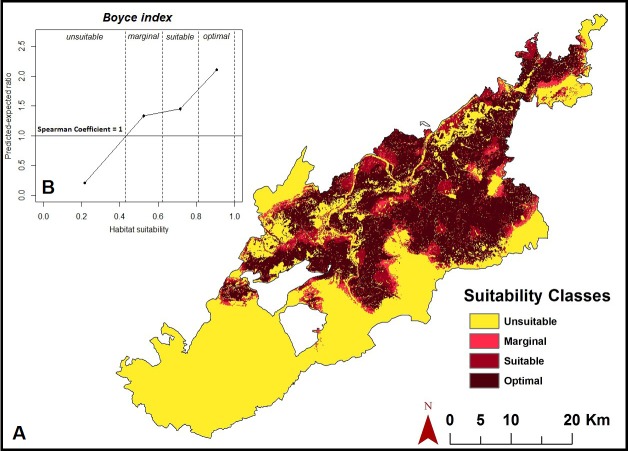
Habitat suitability map.(A) Map depicting habitat suitability for tigers in Panna Tiger Reserve, Madhya Pradesh, India. (B) shows predicted-to-expected ratios (Fi = 1) of evaluation points against 20 habitat suitability classes. The solid horizontal line (Fi = 1) is the curve of a random model, which was used as a threshold between unsuitable (Fi ≤ 1) and potential tiger (Fi > 1) habitats.